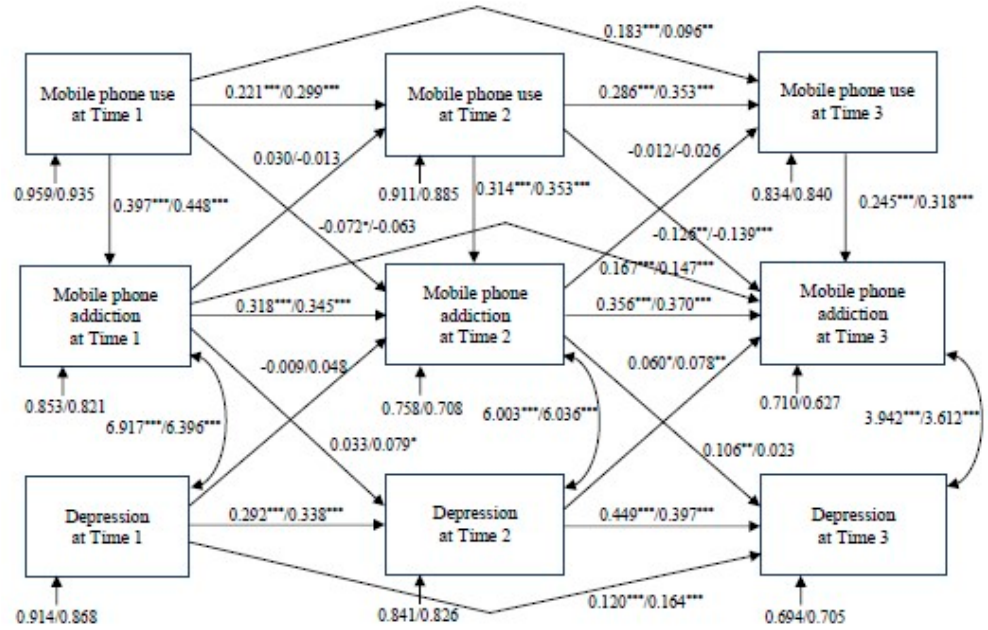
Figure 2. Autoregressive cross-lagged multiple-group structural equation model (Note: *** p < 0.001, ** p < 0.01, * p < 0.05. The first coefficient is the unstandardized path coefficient for boys, the second coefficient is the unstandardized path coefficient for girls. All coefficients are unstandardized path coefficients but disturbance values are standardized. Covariates include two-income family, both parents in the household, father’s education, mother’s education, annual household income, academic activity, compliance with school rules, and youth relationships with peers and teachers).